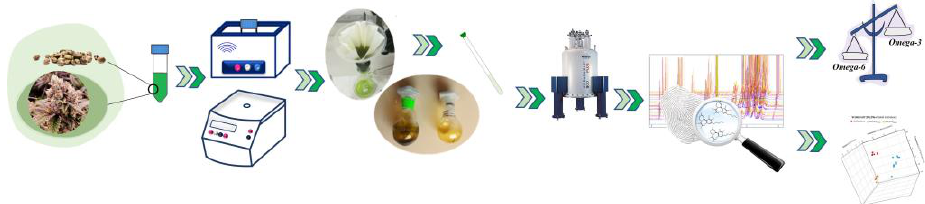
Figure 2. Schematic experimental steps involved in the extraction, sample preparation, and NMR characterization of C. sativa seeds and inflorescences. characterization of C. sativa seeds and